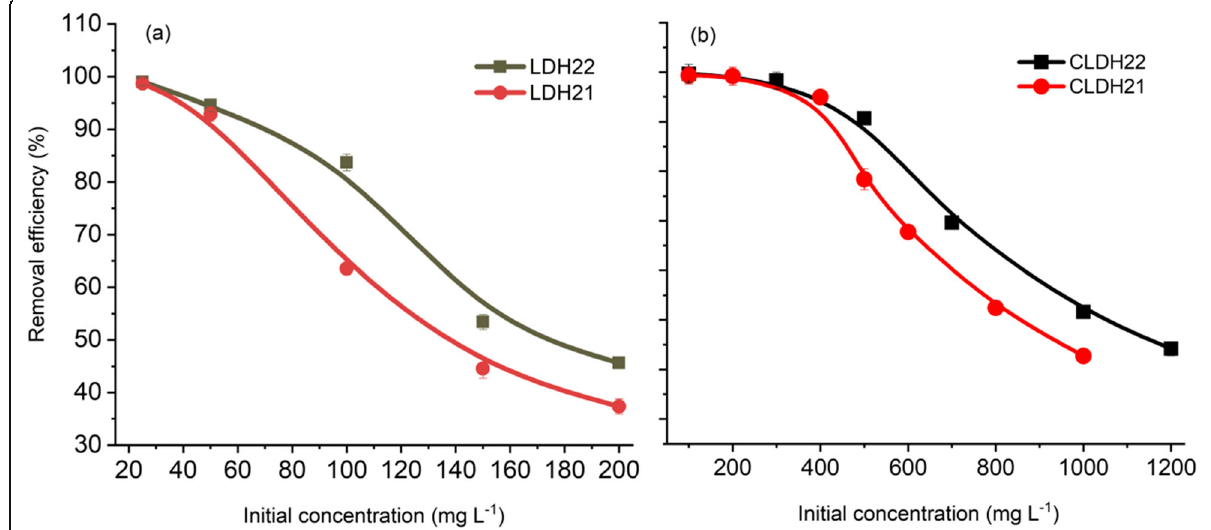
Fig. 7 Effect of initial concentration on removal efficiency of IDB onto LDHs ( a ) and CLDHs ( b ) adsorbent